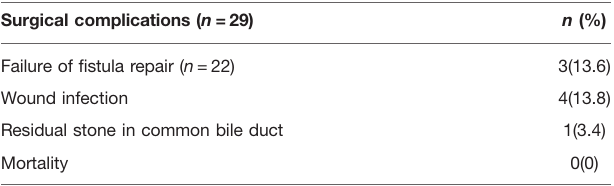
TABLE 5 | Surgical complications of CEF with and without